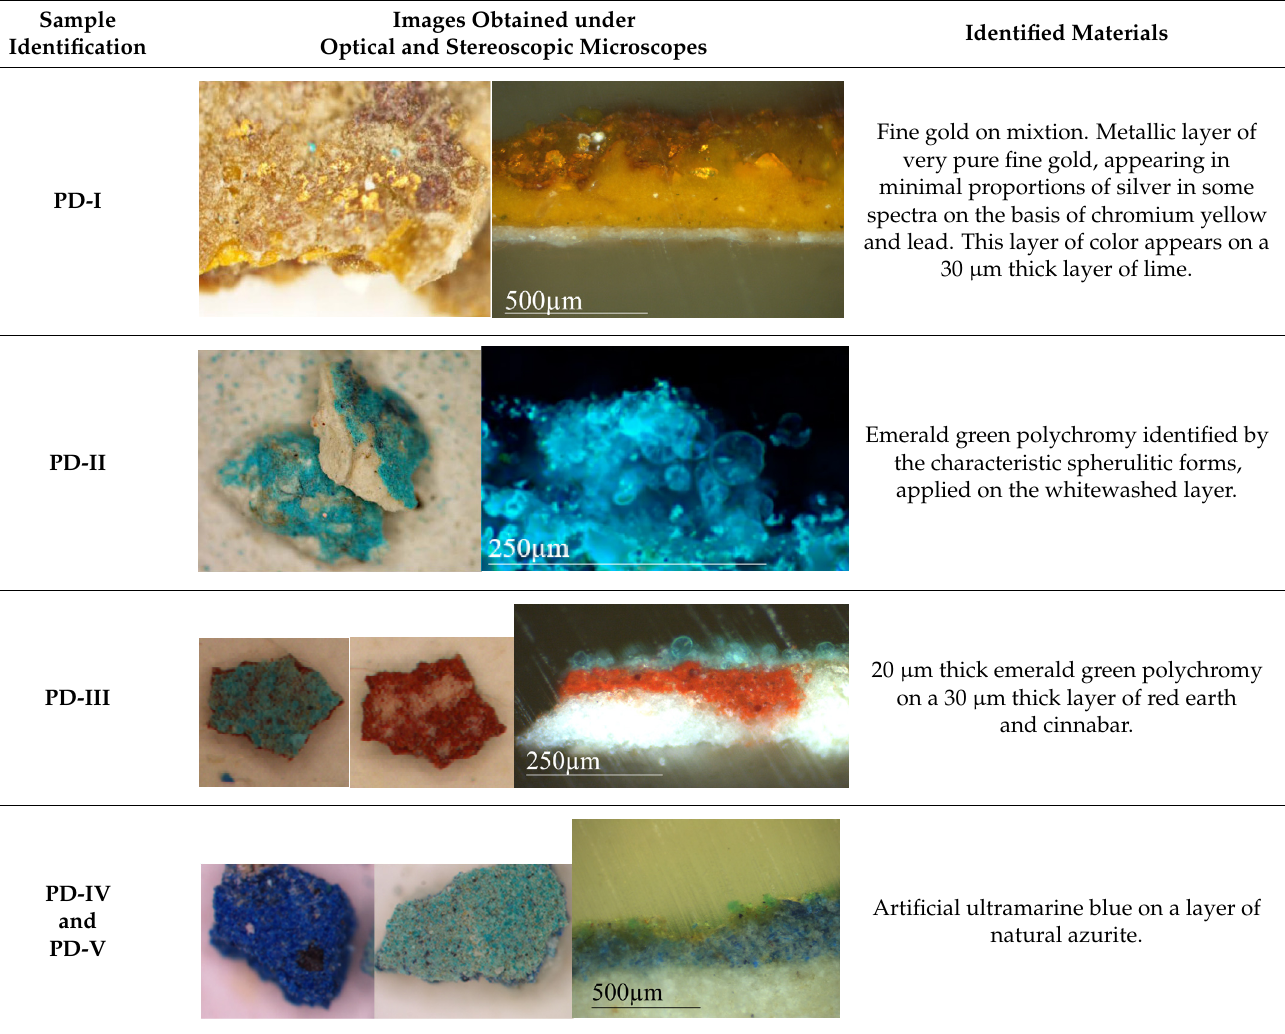
Artificial ultramarine blue on a layer of natural